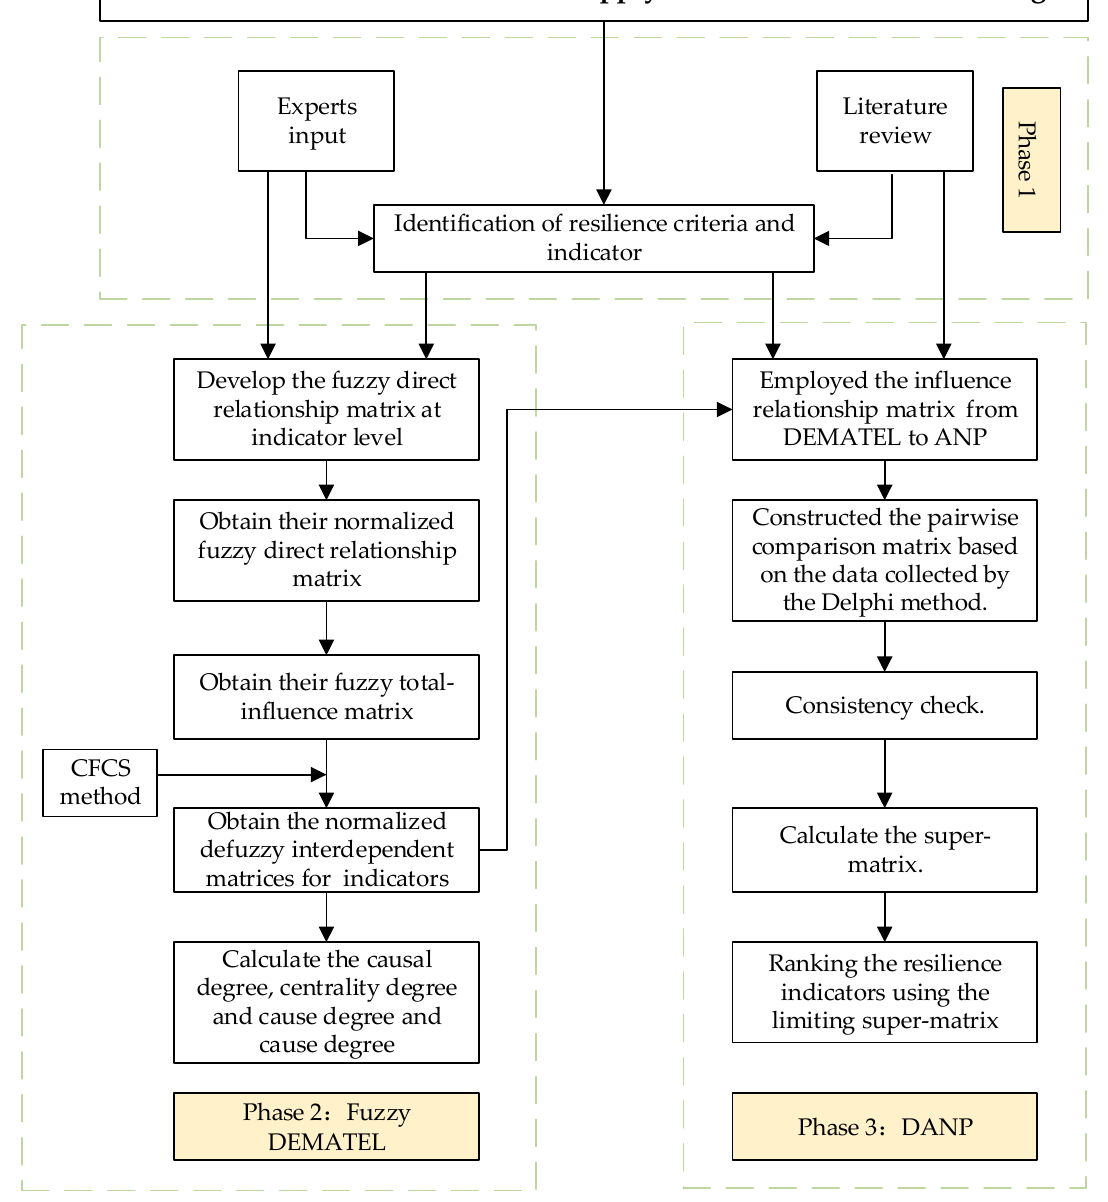
Figure 1. Humanitarian supply chain resilience evaluation framework in flood events.